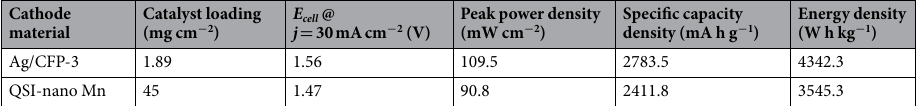
Table 2. A detailed comparison of the Al-air batteries using the as-prepared Ag/CFP-3 electrode and the commercial QSI-nano Mn electrode with key performance